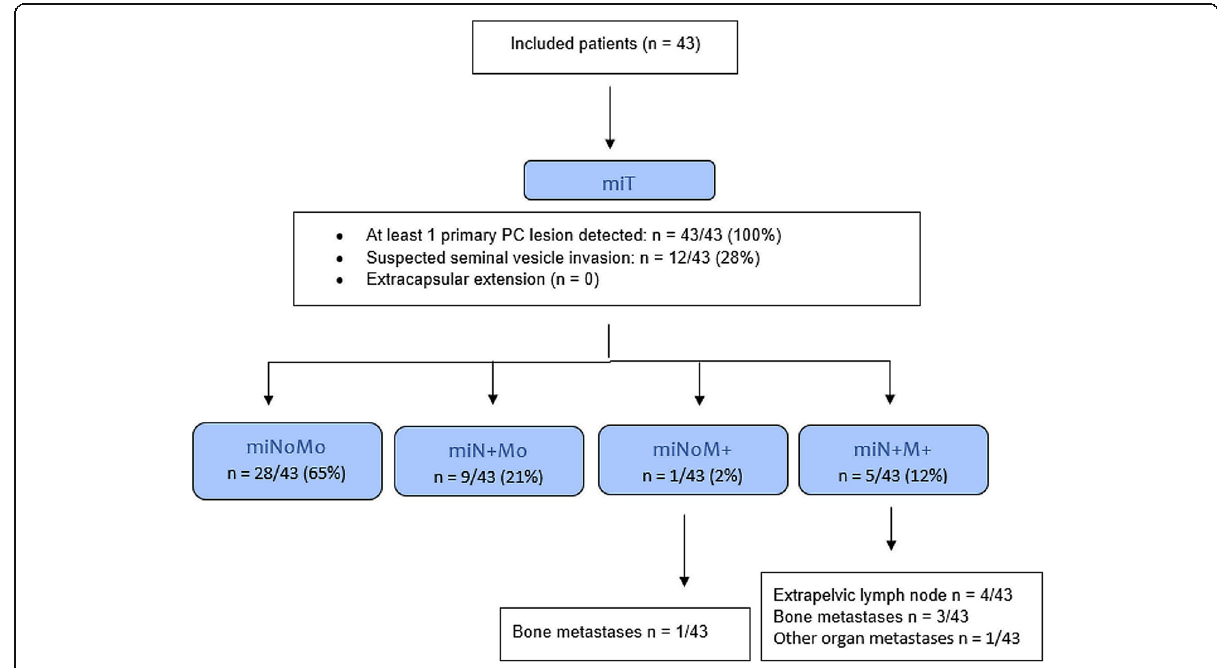
Fig. 1 Flowchart of miTNM classification of patients